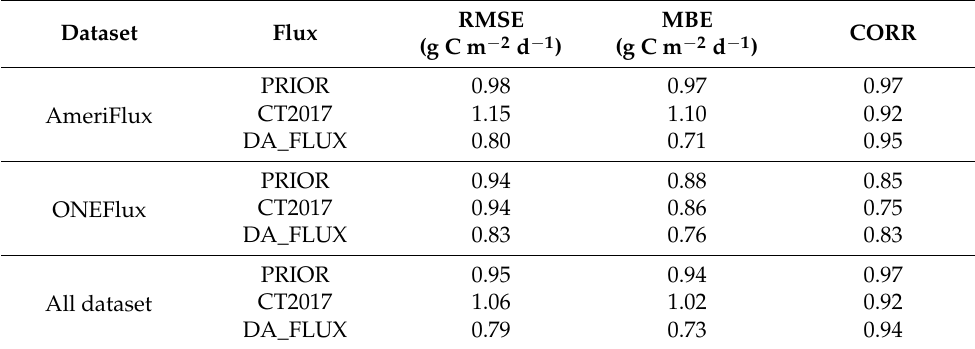
Table 5. Statistical results of comparing the CO 2 flux measurements from AmeriFlux and ONEFlux with the prior (PRIOR), posterior (DA_FLUX) CO 2 flux of the DA_FLUX experiment, and with the posterior CO 2 flux of CT2017.